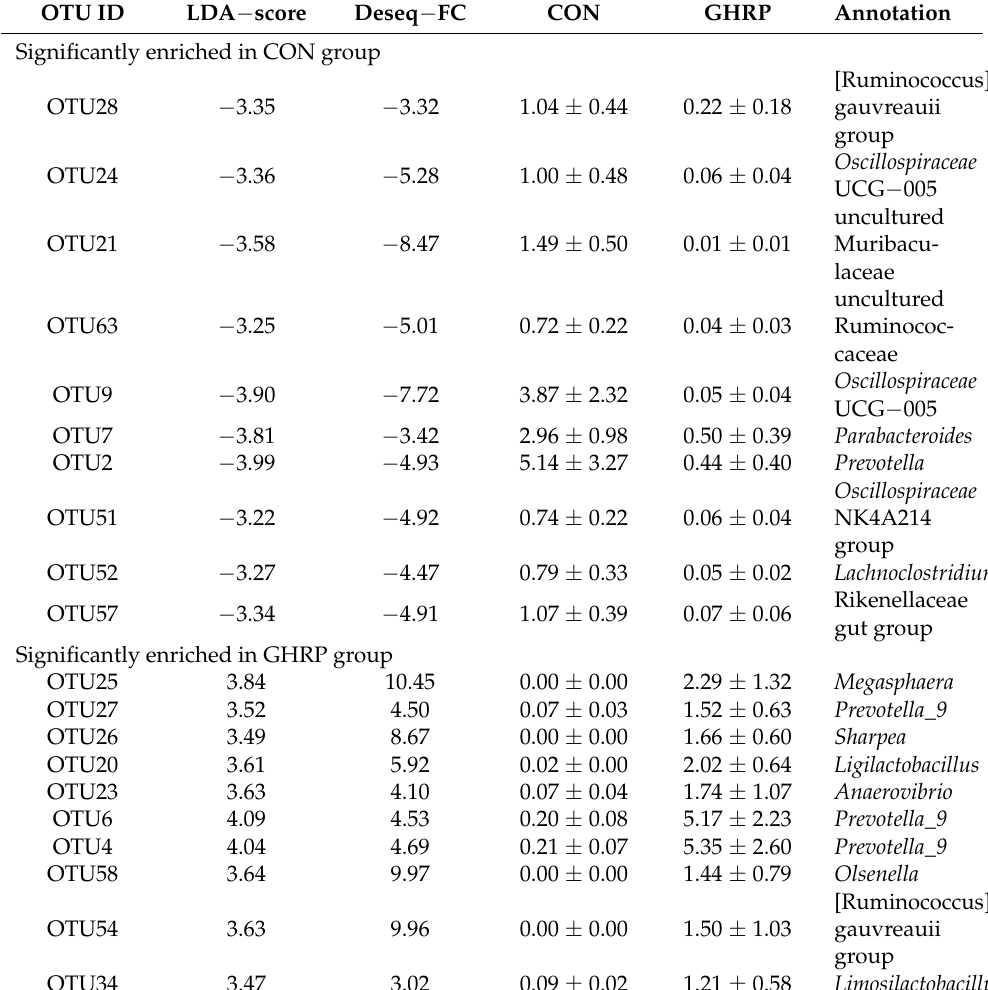
Table 2. Effect of injection of ghrelin antagonist ([D-Lys3]-GHRP-6) on the bacterial OTUs in colonic digesta of